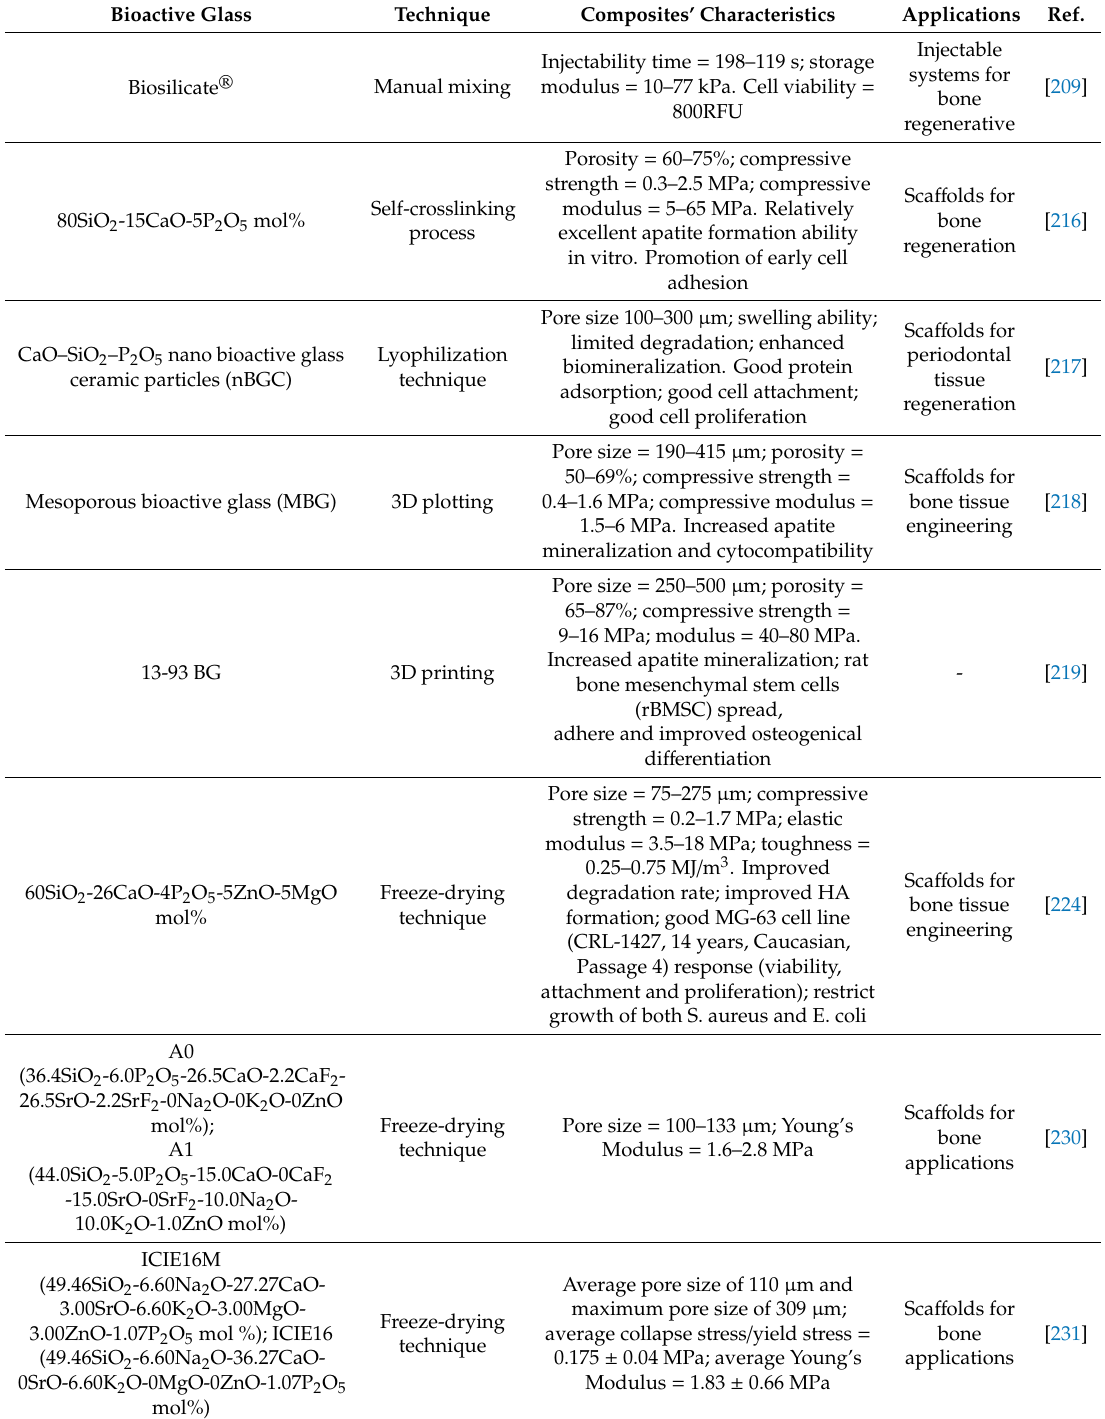
Table 6. Summary of alginate / bioactive glass composites for biomedical